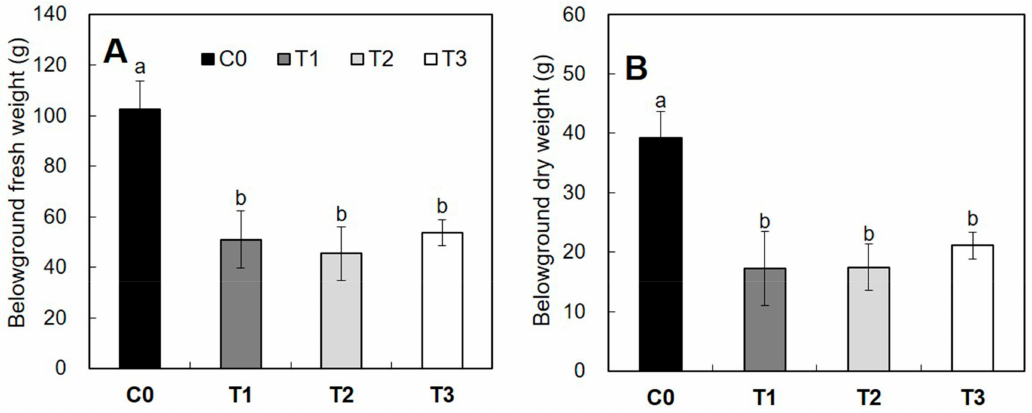
Figure 12. Belowground fresh and dry weight in yellow-poplar exposed to artificial night lighting. ( A ) Fresh weight and ( B ) dry weight in yellow-poplar exposed to the natural day/night cycle (C0, black bars) and the day/night with artificial lighting cycle (T1, T2, and T3 denote dark gray bars, light gray bars, and white bars, respectively). Data indicate mean ± SD ( n = 5). Different lowercase letters on the bars indicate significant differences among treatments (Tukey’s test after one-way